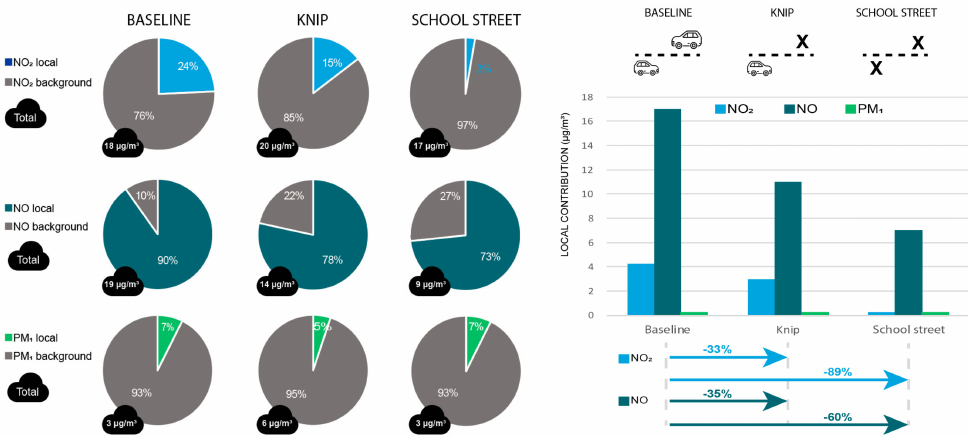
Figure 11. ( Left panel): local and background NO 2 , NO and PM 1 contribution during baseline (left), knip (middle) and school street (right) scenario. ( Right panel): Absolute and relative (%) impacts from knip and school street scenarios on local NO 2 , NO and PM 1